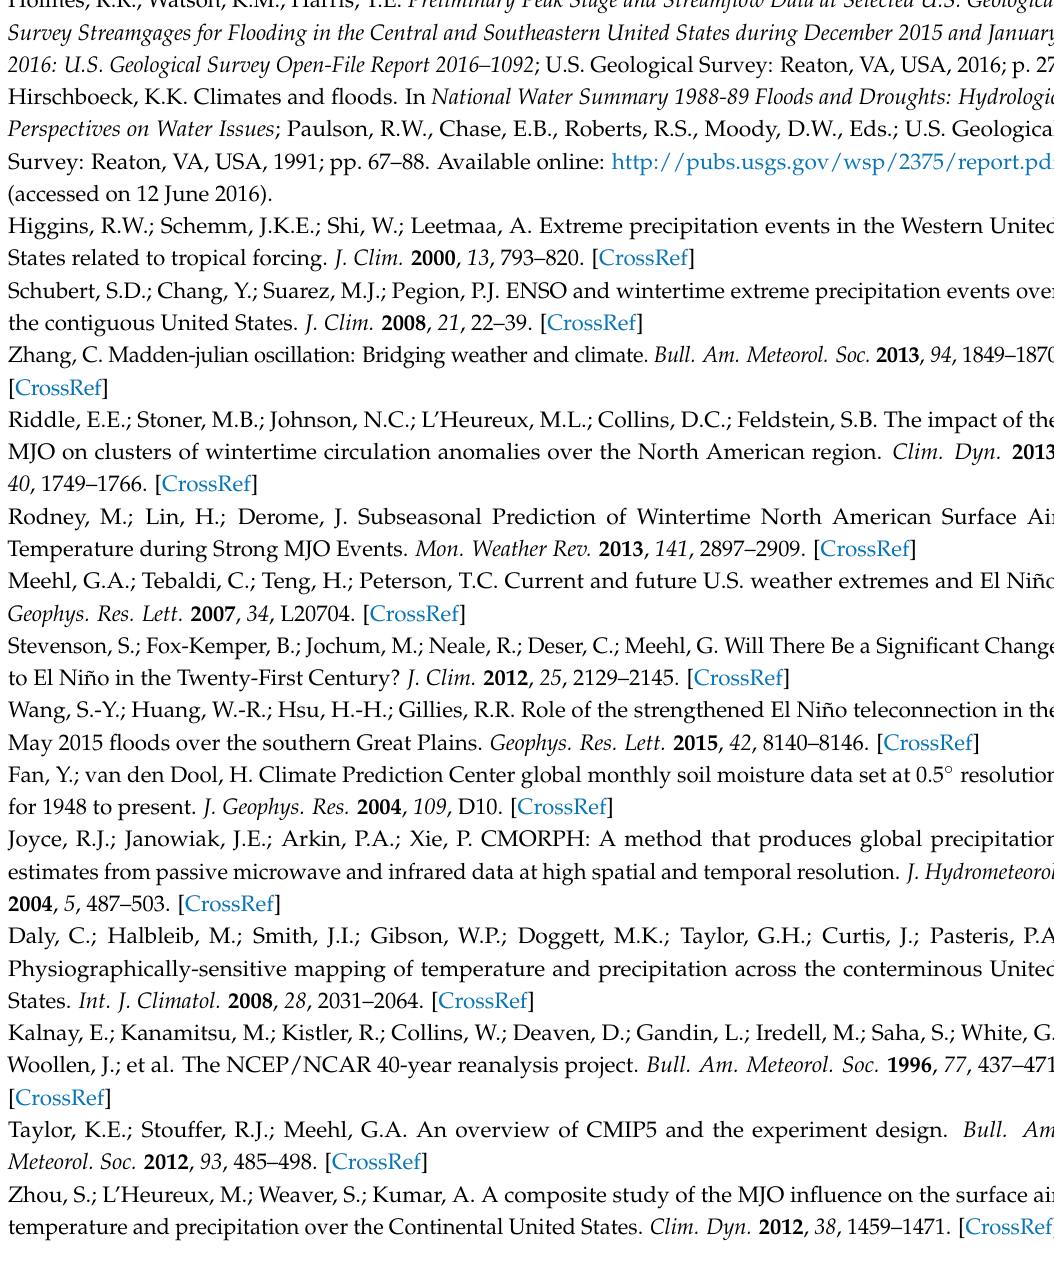
Figure S1: Additional information on the December 2015 MJO episode, Table S1: Full name, institute, ensemble size, and spatial resolution of the CMIP5 models